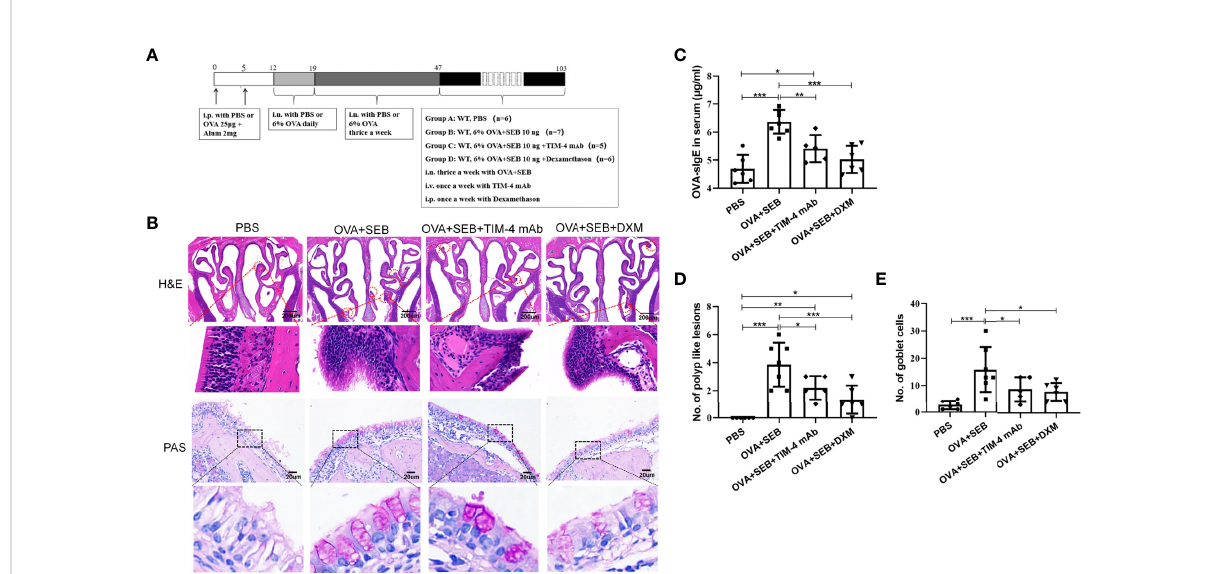
FIGURE 3 Effects of TIM-4 mAb on polypoid lesion formation in the NP murine model. (A) The protocol for the NP murine model. WT mice were sensitized by an i.p. of either PBS or 25 µg of OVA in 2 mg aluminum hydroxide. Then, WT mice were treated with 6% OVA and 10 ng SEB by i.n. administration to induce nasal polyposis, and TIM-4 mAb and dexamethasone were administered to the experimental group. (B – E) The effects of TIM-4 mAb on polypoid lesion formation. (B) Representative polypoid lesions and typical sinonasal mucosa stained by H&E. Morphology and numbers of goblet cells stained by PAS. The criteria for polypoid lesions were described in the methods section and represented with red circles. (C) OVA-speci fi c IgE levels in serum were detected by ELISA. (D) Quantitative summary of the number of polypoid lesions. (E) Quantitative summary of the number of goblet cells. PBS group: n=6; OVA+SEB group: n=7; OVA+SEB+TIM-4 mAb group: n=5; OVA+SEB+DXM group: n=6; TIM-4 monoclonal antibody: TIM-4 mAb; dexamethasone: DXM; Intraperitoneal: i.p.; intranasal: i.n.; intravenous: i.v. H&E pictures are shown at a magni fi cation of 40×, and PAS, IHC, and immuno fl uorescence representative pictures are shown at a magni fi cation of 400×. The insets show a higher magni fi cation of the selected area. Bars show the mean ± SD. *P<0.05, **P<0.01,